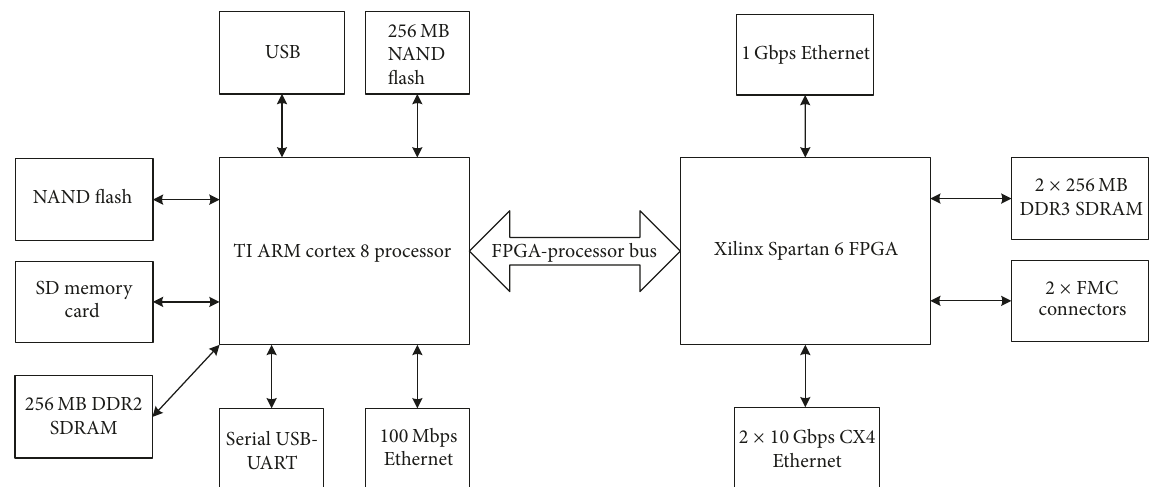
Figure 12: An architecture of RHINO platform building blocks.